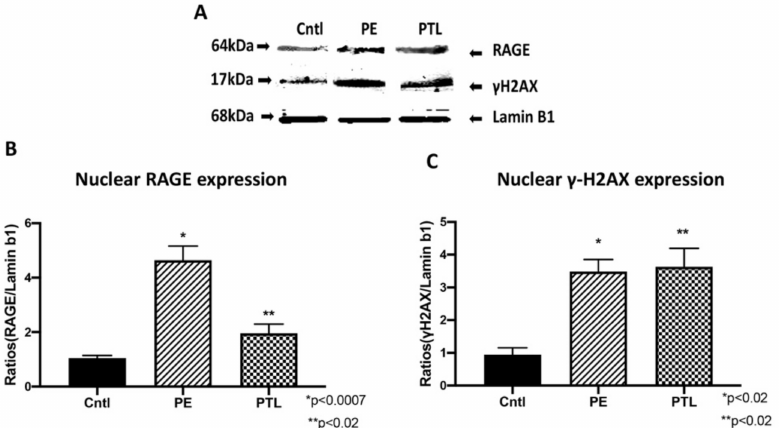
Figure 2. RAGE and placental γ -H2AX nuclear expression. ( A ) characteristic western blot for these experiments. ( B , C ) Elevated γ -H2AX and RAGE protein expression through western blot on PE and PTL samples when compared to